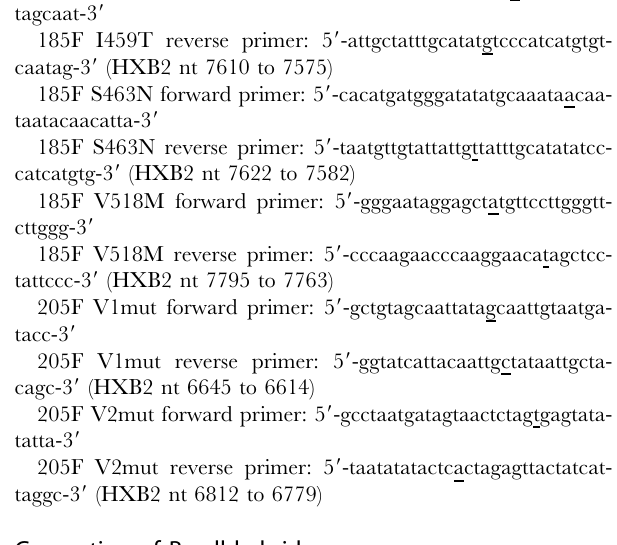
Figure S1 Phylogenetic tree of longitudinal 185F and 205F Envs. A. A neighbor-joining tree was generated using Clustal W v.1.83 for OSX using the entire env nucleotide sequence of 103 185F Envs from 11 time points and 8 Envs from the donor partner 185M at 0- months. A consensus C sequence was used to root the tree. An asterisk indicates a bootstrap greater than 80. Closed symbols indicate Envs from plasma; open symbols indicate Envs from uncultured PBMC DNA. Colors from warm to cool indicate longitudinal time points; squares indicate Envs from the donor partner. A red arrow indicates the two 0-month Envs (PL3.1 and PB3.1) that were used as a background for chimeras and mutants; black arrows indicate Nab resistant Envs used for domain exchange into the chimera. Shaded gray boxes indicate 3 distinct phylogenetic lineages that included 28-month escape variants. B. A neighbor- joining tree was generated using Clustal W v.1.83 for OSX using the entire env nucleotide sequence of 34 205F Envs from 7 time points and 5 Envs from the donor partner 205M at 0-months. A consensus C sequence was used to root the tree. An asterisk indicates a bootstrap greater than 80. Closed symbols indicate Envs from plasma; open symbols indicate Envs from uncultured PBMC DNA. Colors from warm to cool indicate longitudinal time points; squares indicates Envs from the donor partner. A red arrow indicates the